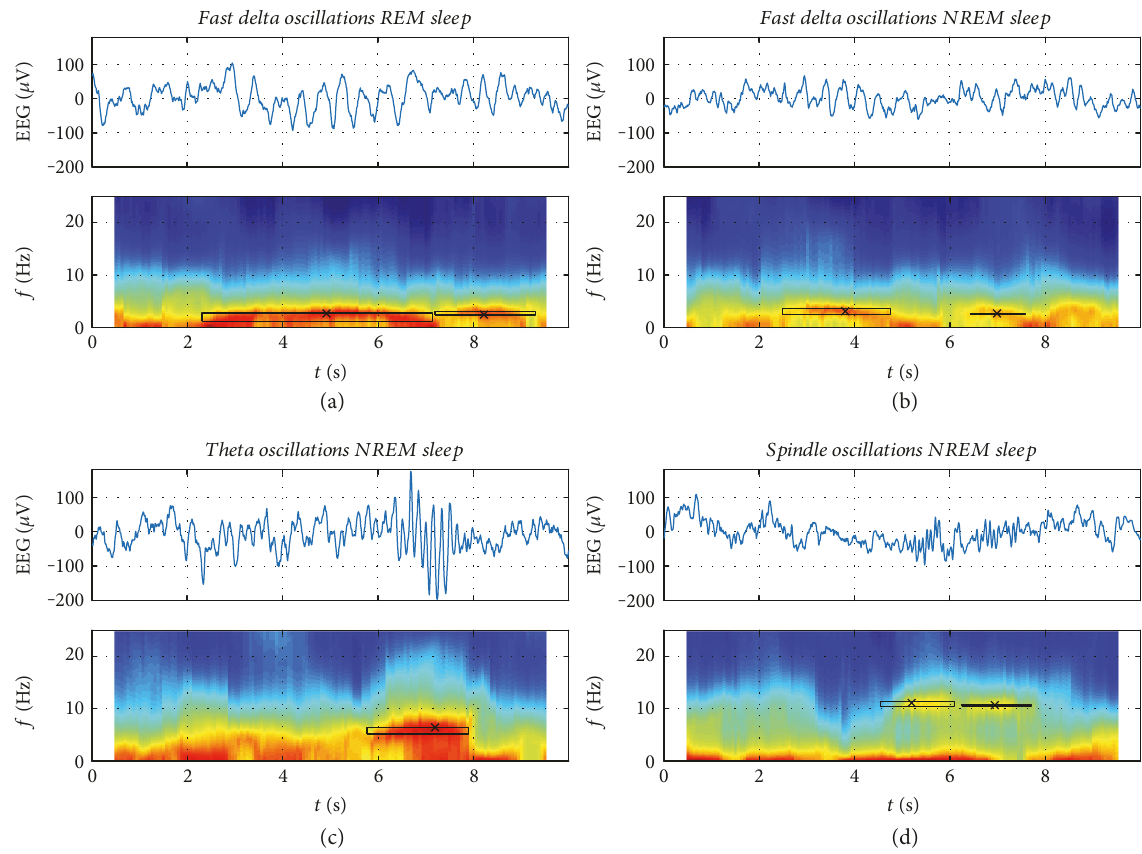
Figure 2: Illustration of single events. For each event, the following data are illustrated: 10 s epoch of EEG data (derivation C3A2) and spectrogram with the detected events marked by a rectangle. The length of the horizontal rectangle indicates the duration of the event and its height the minimal and maximal frequency. The cross indicates the frequency f at the time of minimal damping. Color-coded events spectrogram estimated using AR(8) models on overlapping 1 s segments (warmer colors denote higher power). Spectrograms start 0.5s later and ends 0.5 s earlier due to the fact that a 1s segment was moved through the data. All data are from children at 3 years. (a) Fast delta oscillations in REM sleep (same child shown in Supplementary Figure S 2 ); (b) fast delta oscillations in NREM sleep stage 2 (same child shown in Supplementary Figure S 2 ); (c) theta oscillations in NREM sleep stage 2 (same child shown in Supplementary Figure S 4 ); and (d) sleep spindles in NREM sleep stage 2 (same child shown in Supplementary Figure S 6 ) are